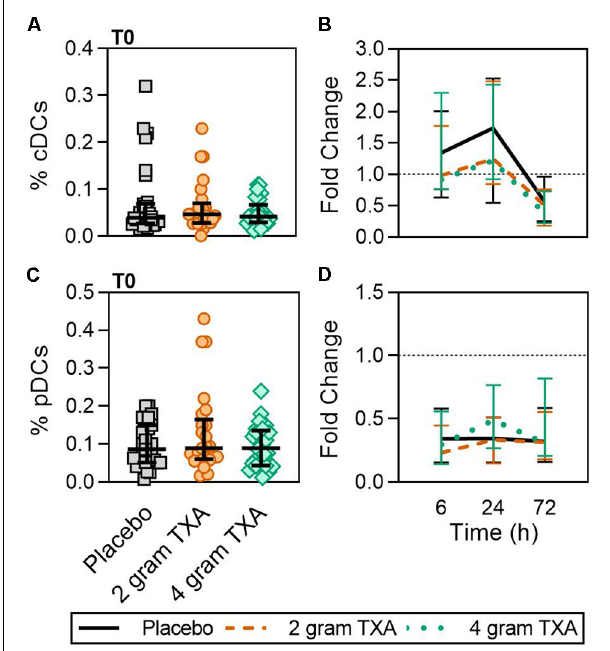
FIGURE 5 | TXA administration does not alter conventional or plasmacytoid DC population changes in response to trauma. For T0, data are represented as individual points with median + IQR for error bars. For all kinetic data, fold change was calculated as [(frequency/MFI/concentration of a given population/analyte at the given time | | T6,T24,T72| |) ÷ (frequency/MFI/concentration of the same population/analyte at T0)]. Data are displayed as line graphs (fold change, median + IQR). The dashed line placed at y = 1 represents T0, or baseline. Placebo, n = 29; 2 g TXA, n = 24; 4 g TXA, n = 25. Statistical differences between the 4 g TXA and placebo groups at each given time point, as calculated via Kruskal-Wallis, are noted as follows: p > 0.05, not significant and not denoted on the graphical representation. (A) The frequency of conventional dendritic cells (cDCs) found in total peripheral blood leukocytes at T0 in all three treatment groups. (B) Fold change in frequency of cDCs found in total peripheral blood leukocytes over the study period of 72 h. (C) The frequency of plasmacytoid dendritic cells (pDCs) found in total peripheral blood leukocytes at T0 in all three treatment groups. (D) Fold change in frequency of pDCs found in total peripheral blood leukocytes over the study period of 72